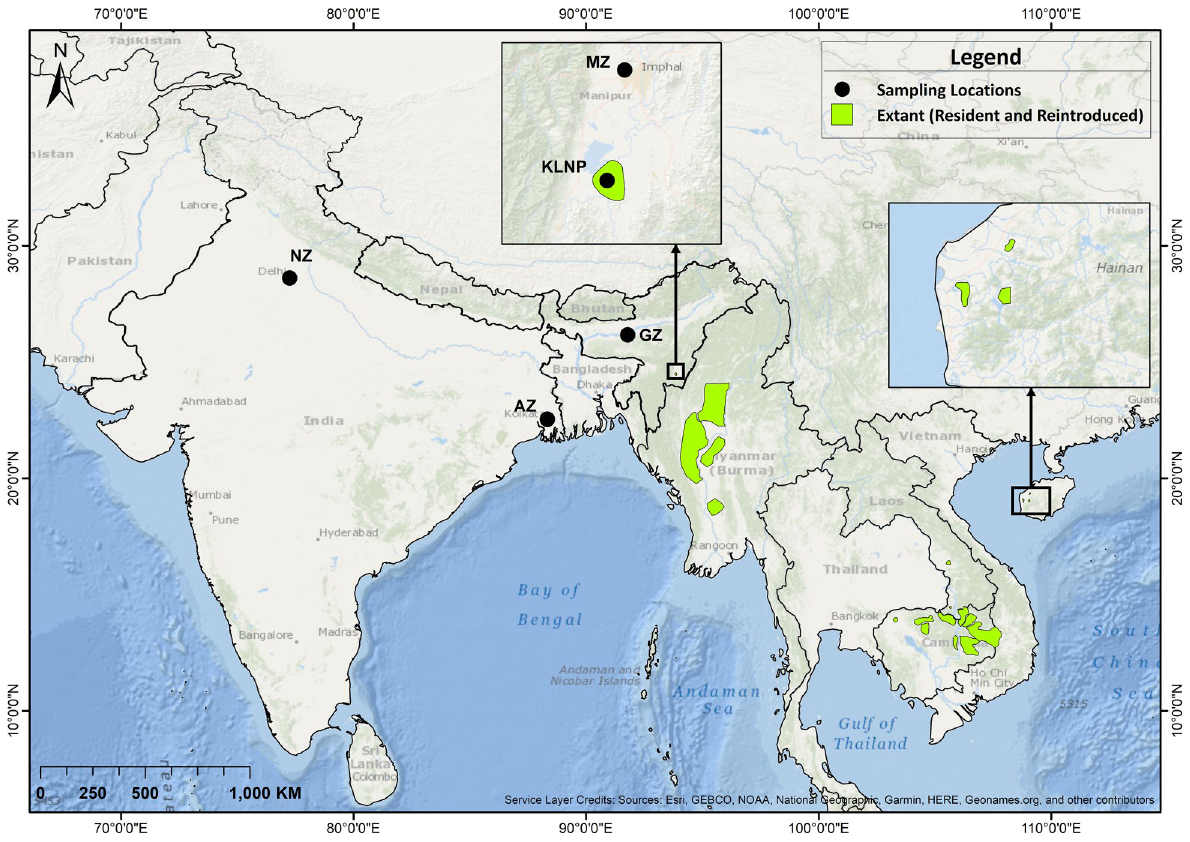
Zoological Garden, West Bengal; GZ Assam State Zoo, Assam; MZ Manipur Zoological Garden, Manipur; KLNP Keibul Lamjao National Park, Manipur. The map was created using ArcGIS v.10.3.1 software developed by ESRI (https